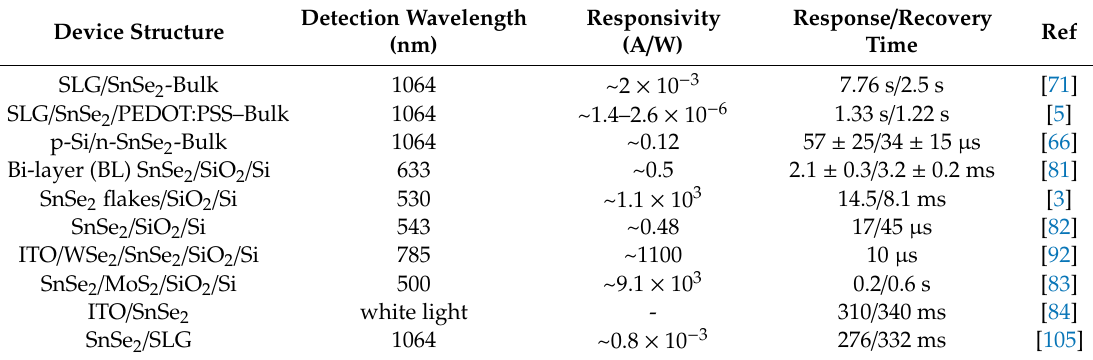
Table1. Wavelengthrange,responsivity,response / recoveryspeedofSnSe 2